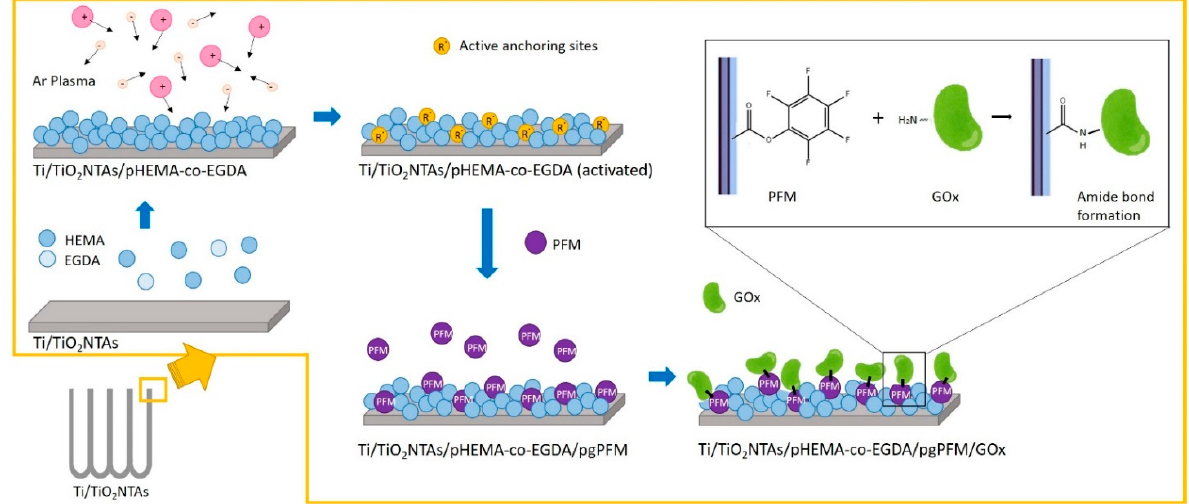
Figure 1. Scheme showing the covalent immobilization process. First, a plasma modification technique was used to obtain ppHEMA-co-EGDA/pgPFM film. Then, covalent immobilization of GOx was undertaken via amide bond formation.